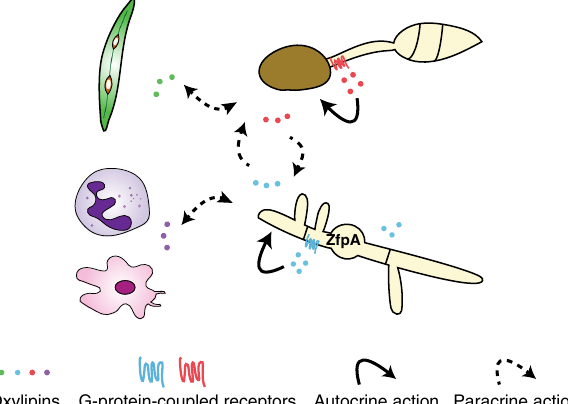
G-protein-coupled receptors Autocrine action Paracrine action Oxylipins Fig. 8 Model of autocrine and paracrine activities of fungal oxylipins. Autocrine activities of endogenous oxylipins, such as 5,8-diHODE produced in A. fumigatus and 7,8-diHODE produced in M. grisea , direct hyphal branching and appressorium formation in the respective fungal species. These oxylipins regulate cellular differentiation likely through G-protein- coupled receptors (GPCRs) and in A. fumigatus , through the transcription factor ZfpA. Secreted oxylipins can exert paracrine effects on neighboring organisms, including other fungi occupying a common niche and plant and animal host immune cells during fungal